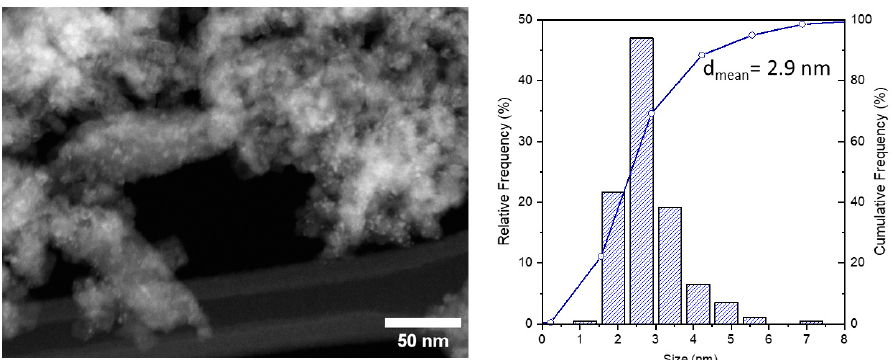
Figure 3. Representative HAADF-STEM micrograph of the fresh CuO@SiO 2 -MN and related histogram of particle size distribution.